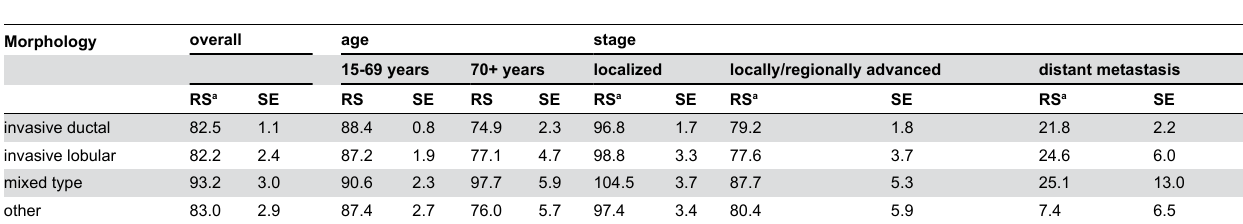
Table 3. Five-year relative survival of female patients from Saarland with invasive breast cancer (ICD-10 code: C50) by tumor morphology and stratified by age and stage estimated for the calendar period 2005-2009 based on completed